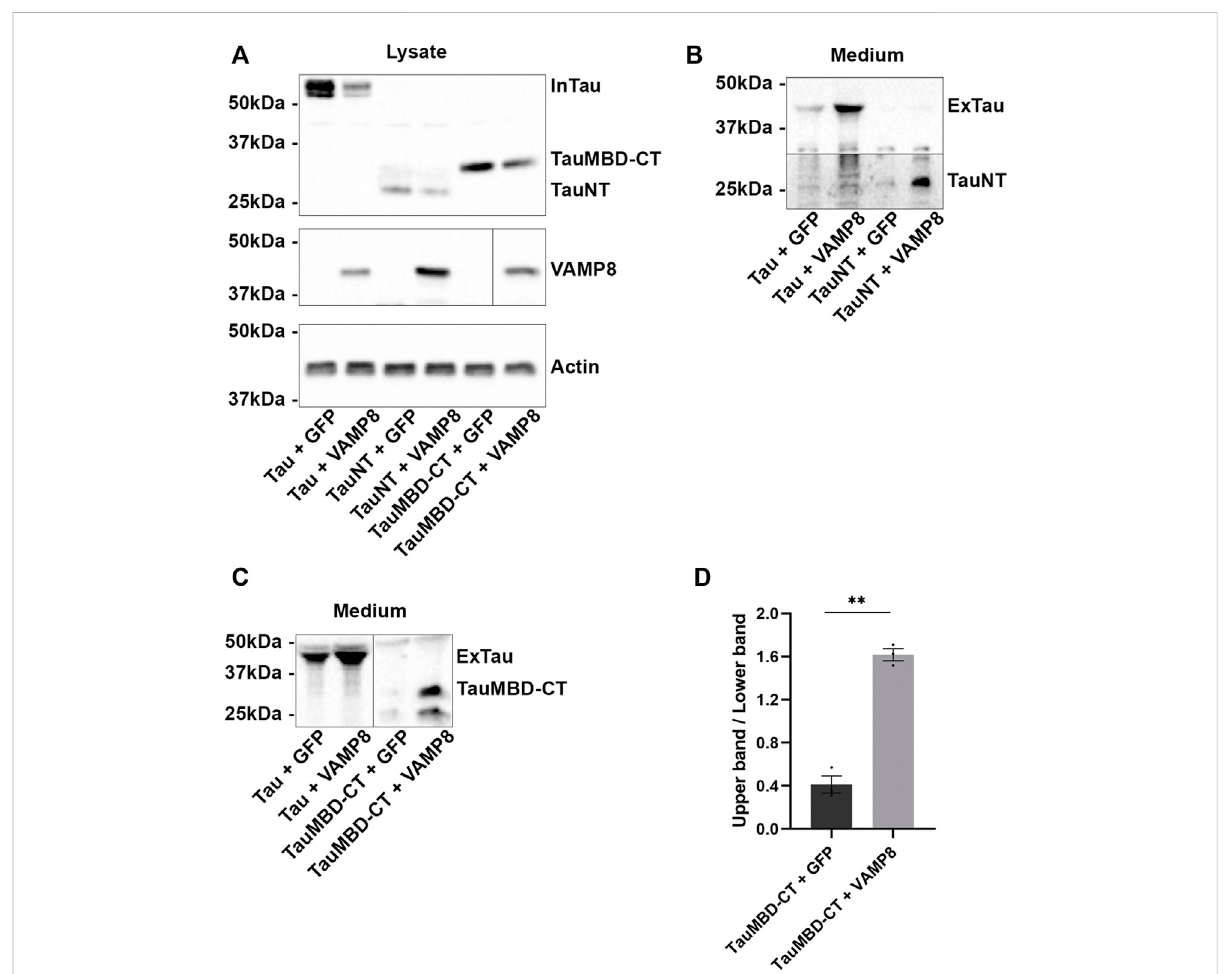
FIGURE 6 Secretion of Tau mediated by VAMP8 is independent of C-terminal cleavage. N2a cells were transfected either with Flag-Tau and GFP-empty, Flag-Tau and GFP-VAMP8, Flag-TauNT and GFP-empty, Flag-TauNT and GFP-VAMP8, Flag-TauMBD-CT and GFP-empty or Flag-TauMBD-CT and GFP-VAMP8 plasmids for 48 h. (A) Representative Western blot with the anti-FLAG antibody for intracellular signal of Tau, TauNT and TauMBD-CT. (B) RepresentativeWesternblotwiththeanti-TauantibodyHT7torevealextracellularTauNT. (C) RepresentativeWesternblotwiththeanti-Tau antibody A0024 to reveal extracellular TauMBD-CT. (D) Densitometry analysis of the upper band/lower band ratio for TauMBD-CT. Black frames were used to mark the splice sites of immunoblot images. n = 3. Data represent scatter plot and mean±SEM. ** p <